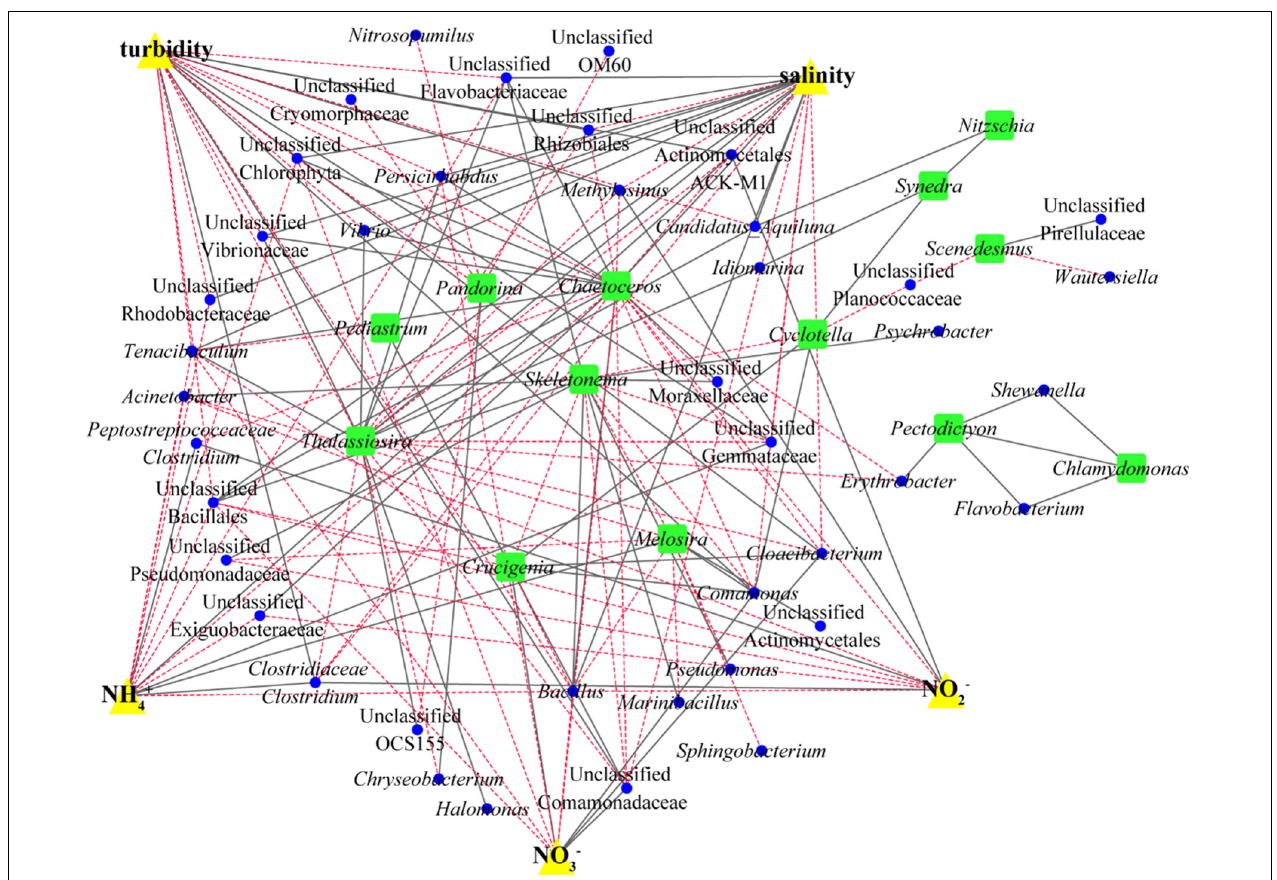
FIGURE 4 | Network analysis reveals trends in plant-adapted and beneficial bacteria. A Spearman correlation network was determined for taxa with average relative abundance greater than 1%. Significant positive correlations ( P < 0.05) (solid gray lines) and negative correlations (dotted red lines) between microalgae (green dots) and bacterial OTUs (blue dots). Correlations between different phytoplankton groups are also shown as well as correlations between different bacterial